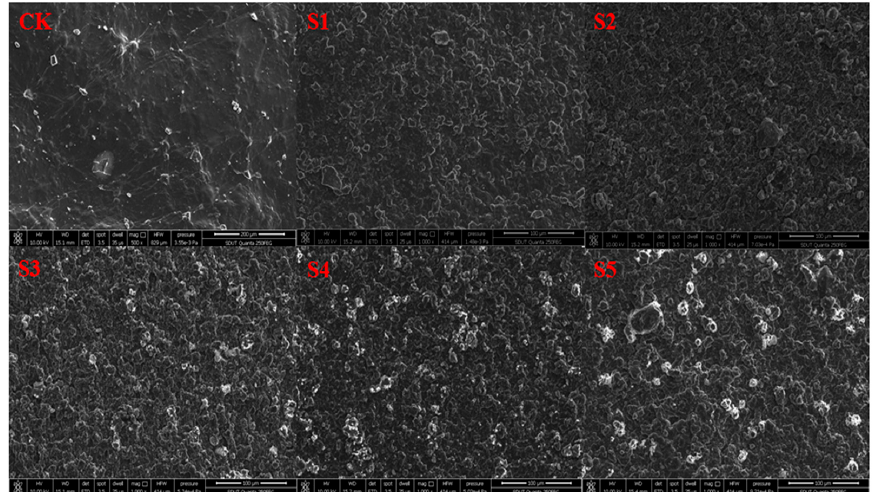
Figure 4. Scanning electron microscopy (SEM) images of KGM/KC films (CK) and KGM/KC/nano-silica films with different nano-silica dosages. (CK: 0% nano-silica; S1: 0.1% nano-silica; S2: 0.2% nano-silica; S3: 0.3% nano-silica; S4:0.4% nano-silica; S5:0.5% nano-silica).